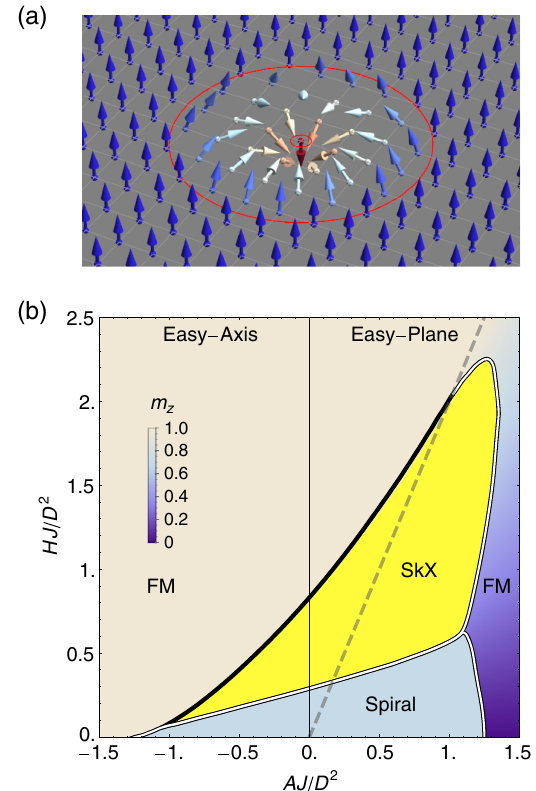
FIG. 1. Skyrmion and T ¼ 0 phase diagram . (a) A skyrmion configuration. (b) The anisotropy-field phase diagram with ferromagnetic (FM), spiral, and skyrmion crystal (SkX) phases for D=J ¼ 0 . 01 and A c J=D 2 ¼ 1 = 2 , with A ¼ A c þ A s . Double lines denote first-order transitions, while the single line is an unusual first-order transition with a divergent length scale; see text. The dashed line H ¼ 2 A separates the out-of-plane FM from the tilted FM. For the FM, m z is shown in the color bar. Results are obtained from a circular-cell variational calculation.